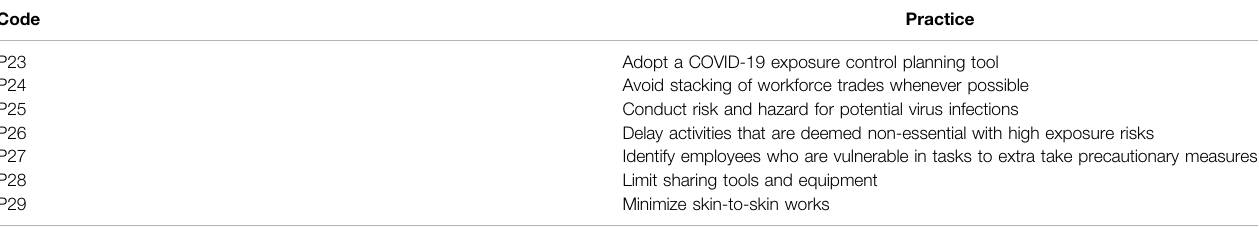
TABLE 6 | Recommended practices to asses ’ daily tasks and activities.